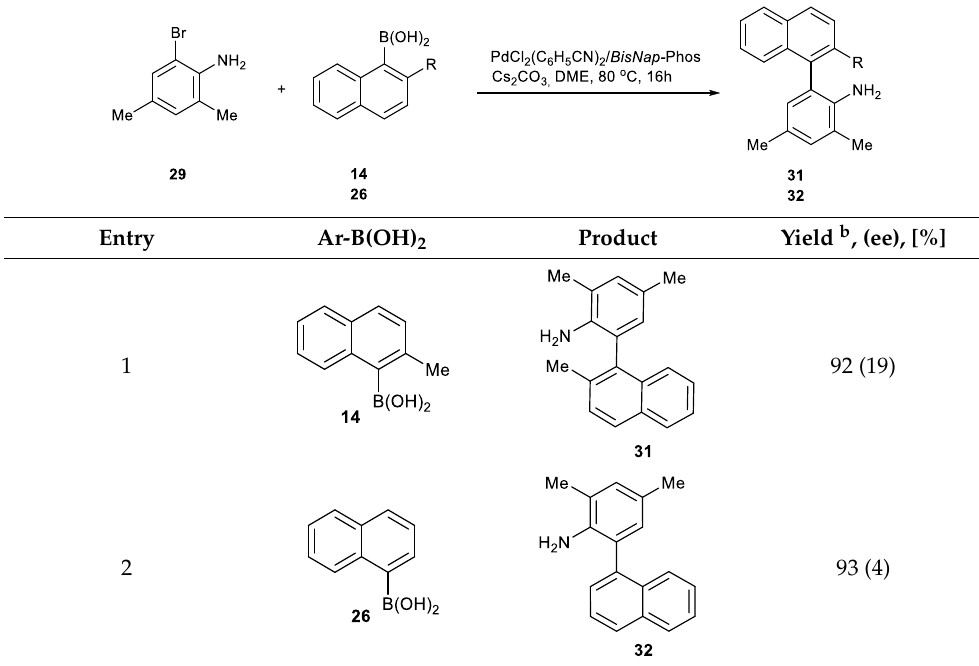
Table 15. Asymmetric synthesis of biaryls 31 and 32 bearing unprotected amino groups a .